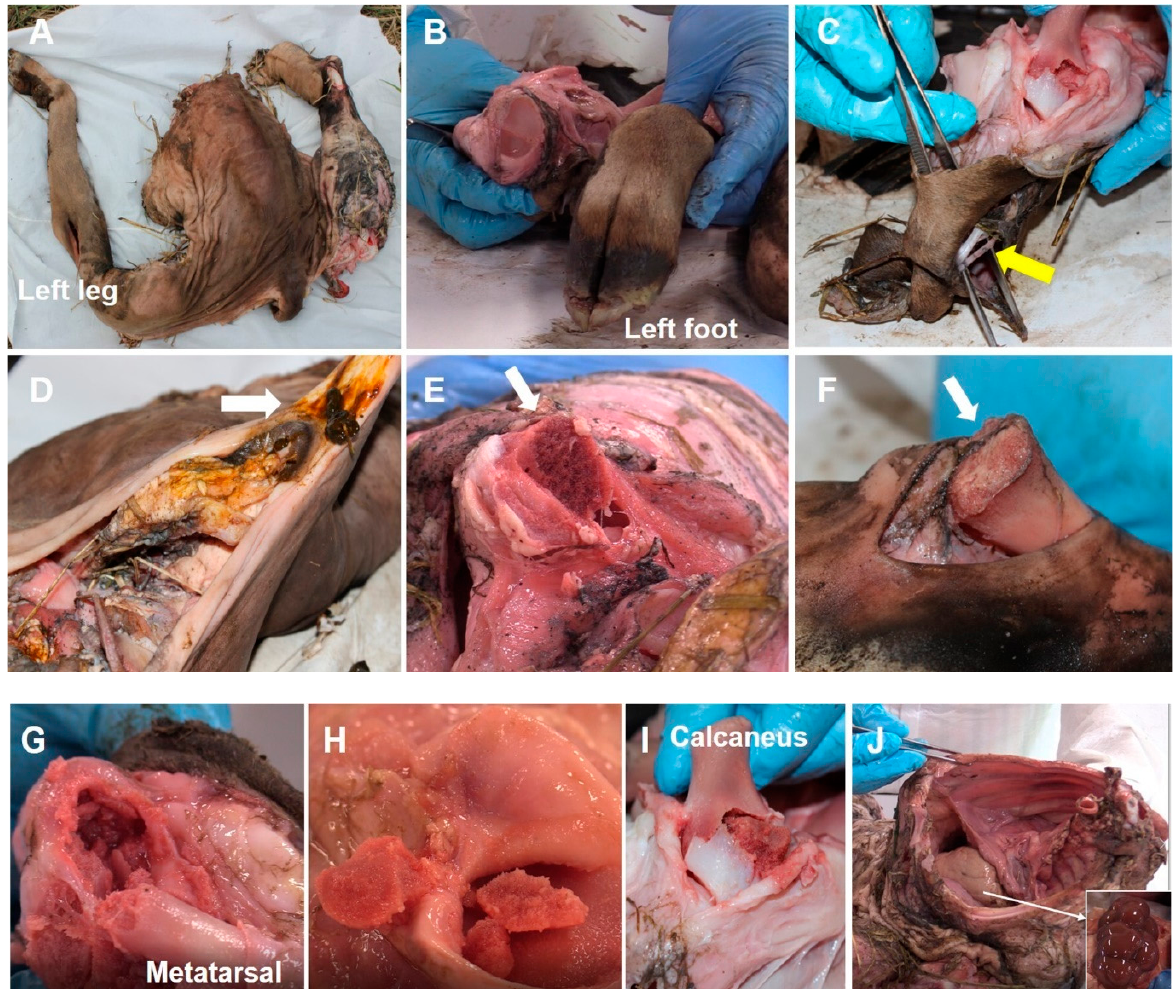
Figure 9. ( A , B ) Showing severe mine blast injuries (effects) in the experimentation field and laboratory, respectively. Comparison of complete amputation of the right foot and survival of the left foot; ( C ) The effects of exposure passed through the fascial planes giving rise to the classic umbrella effect of the remaining soft tissues. It is even possible to see pieces of tendons and nerves still present; ( D ) Destruction of the facial planes in the perineal and genital zones; ( E ) Transversal fracture of the proximal metaphysis of the right femur (white arrow); ( F ) Transversal fracture of the distal metaphysis of the right tibia (white arrow). In the small lower box, luxation of the distal epiphyses of the left tibia; ( G ) Luxation of the distal epiphyses of the left metatarsal bone; ( H ) Comminuted fracture on the dislocated distal epiphysis of the left metatarsus; ( I ) Fracture of the calcaneus; ( J ) Abdominal cavity without viscera after the explosion. Only a depleted urine bladder with ligaments and the right kidney (out of its normal position) are still present in the abdominal cavity. The small lower box shows, the external integrity of the right kidney.